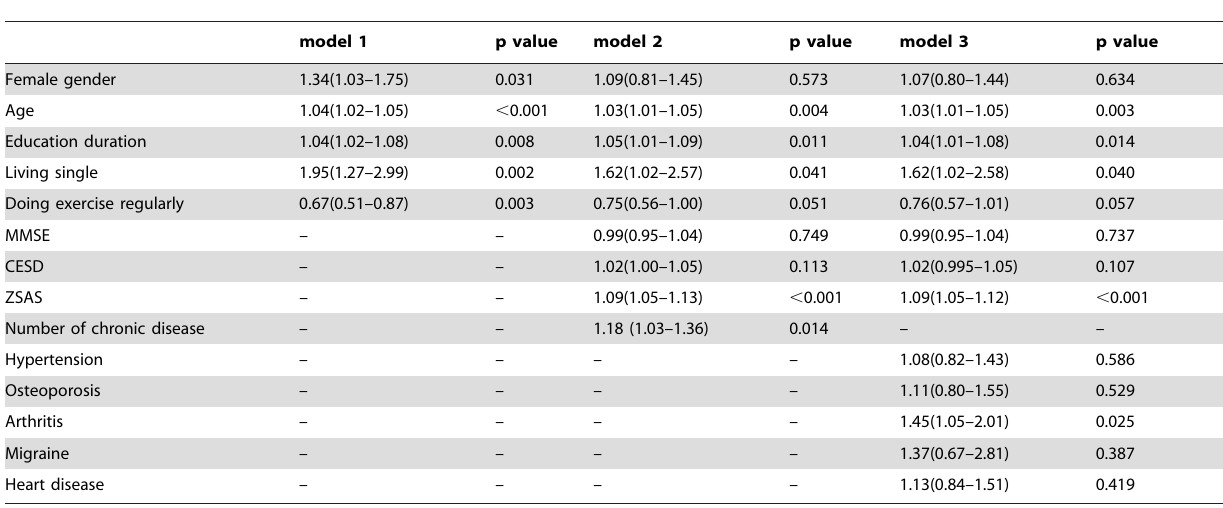
Table 4. Multiple logistic regression models of factors associated with poor sleep